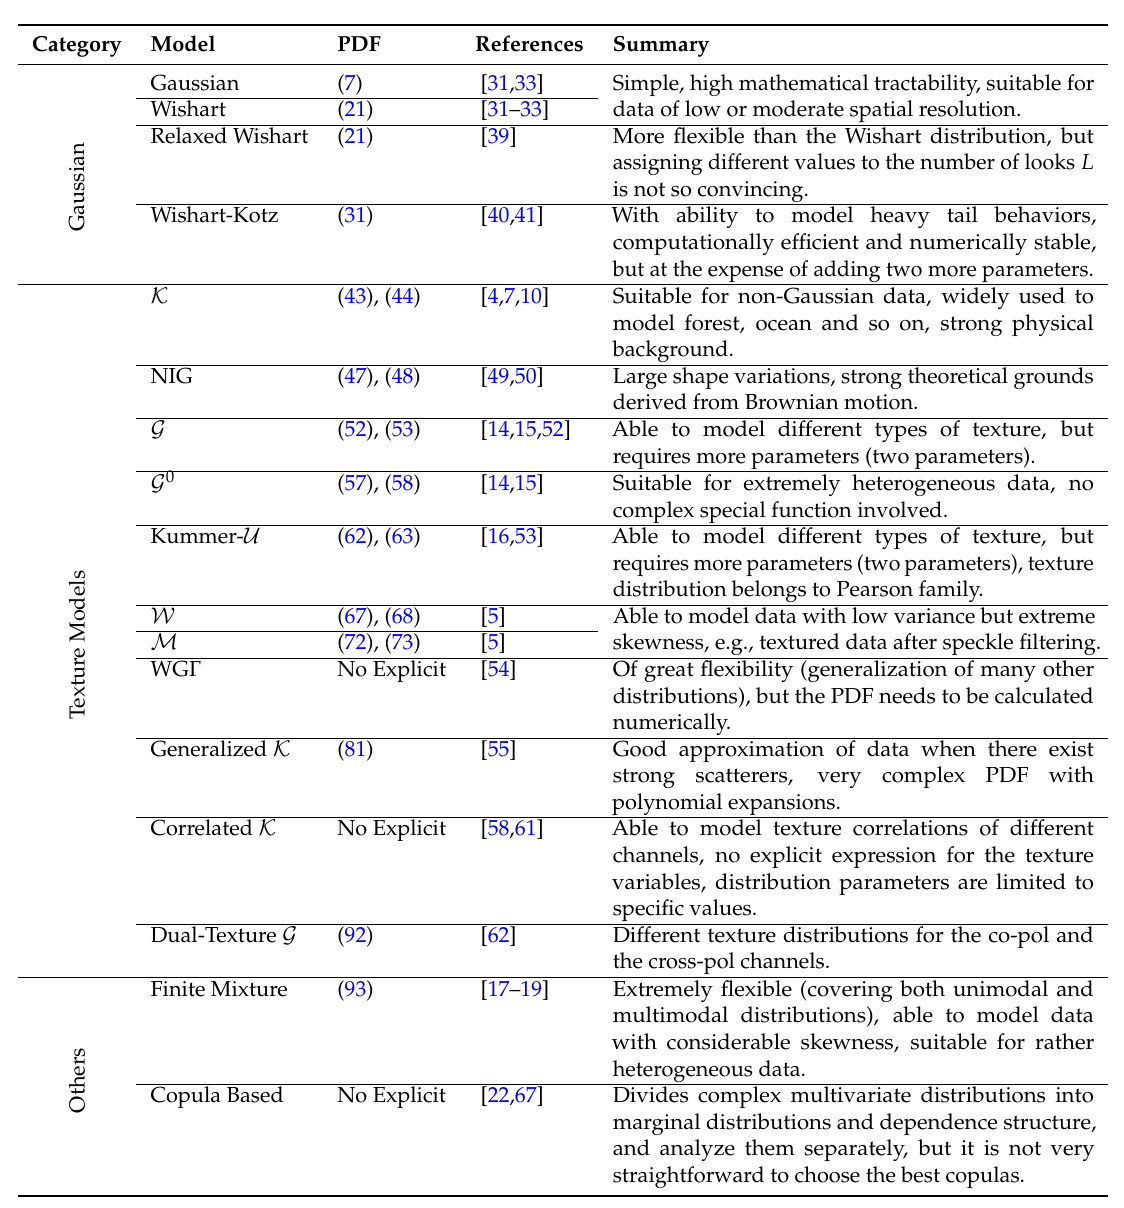
Table 1. Summary of statistical PolSAR data